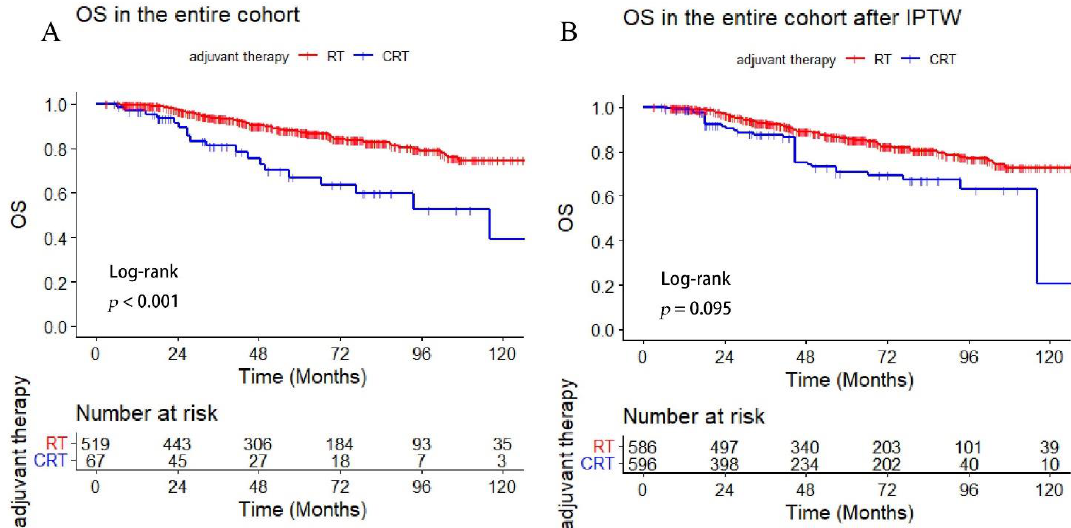
Figure 1. Comparison of survival between the adjuvant CRT and RT group ( A ) OS in the entire cohort, ( B ) OS comparison between treatment groups after IPTW. In the subgroup of patients with LEC, no significant difference in OS was found between the CRT and RT groups ( p = 0.86). In addition, the similar result was ob- tained after IPTW matching with the T stage, N stage, sex, age, PNI, and LVI. Addi- tionally, adjuvant CRT was associated with poor OS in the SDC subtype ( p < 0.001) (Supplementary Figure